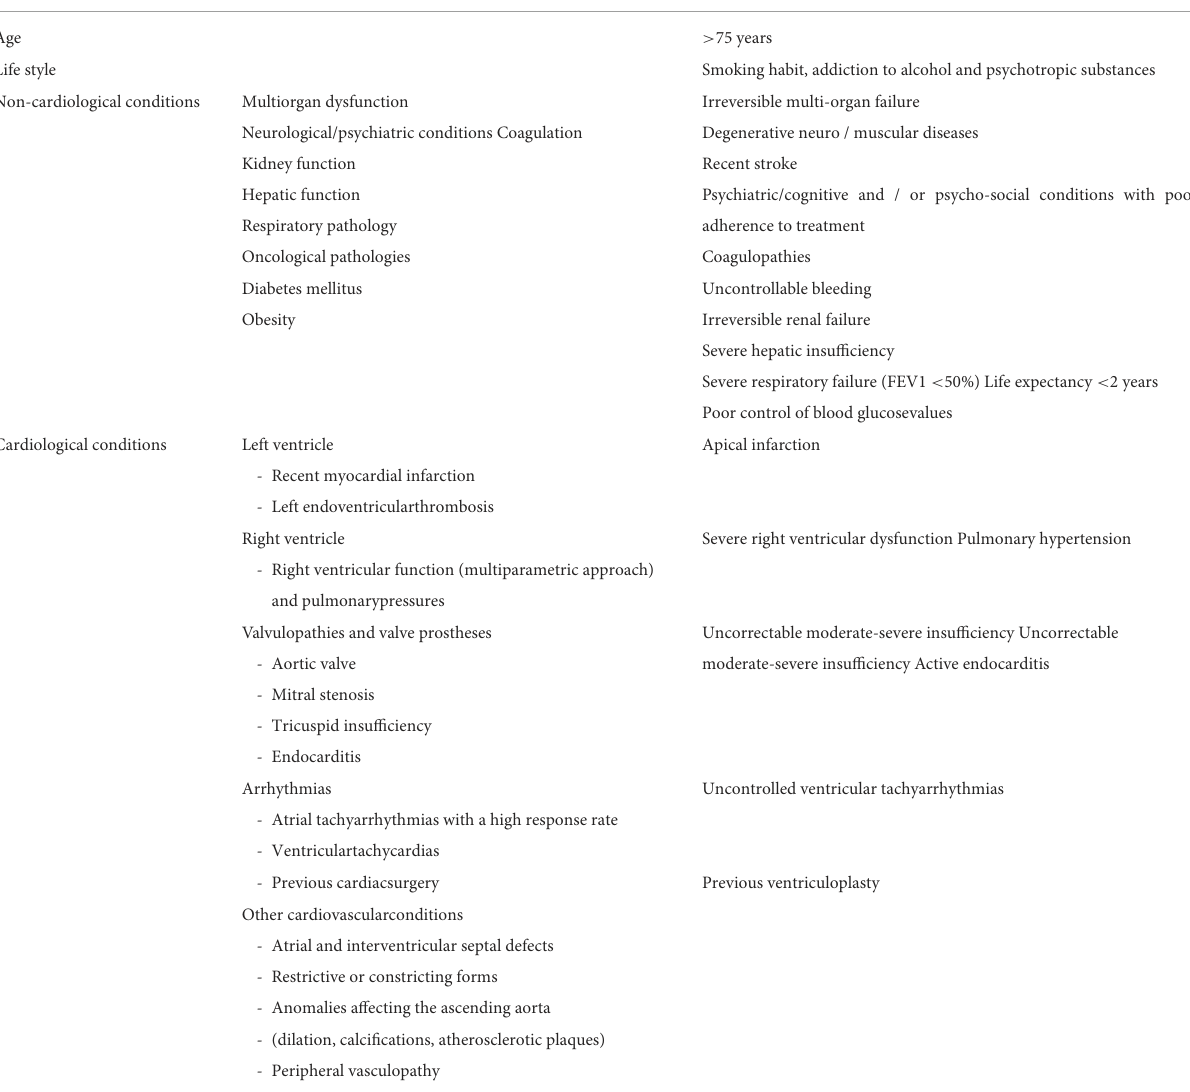
TABLE 3 General evaluation in the patient candidate for left ventricular assist